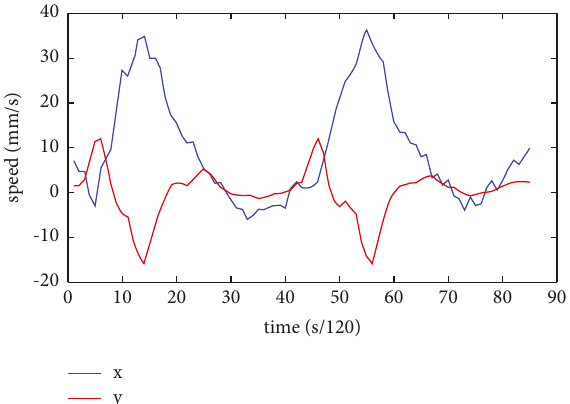
Figure 16: The actual speed